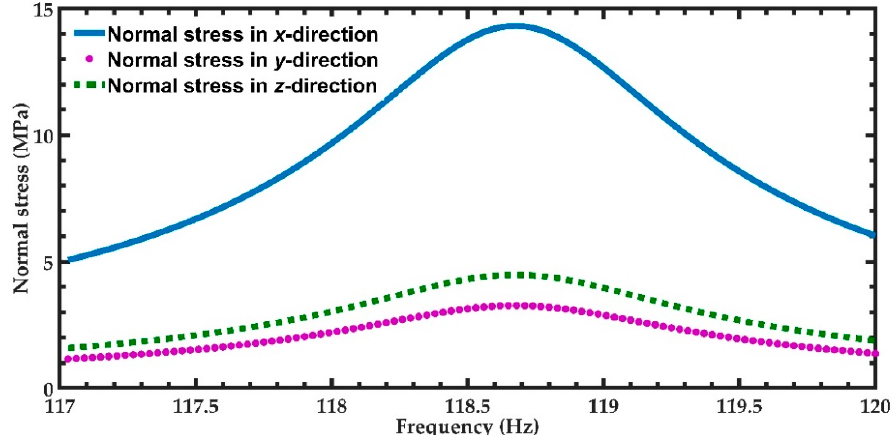
Figure 10. Voltage and output power generated by the nanogenerator considering vibrations (0.0879 m/s 2 ) along the y -axis at office desk (0.0879 m/s 2 ).